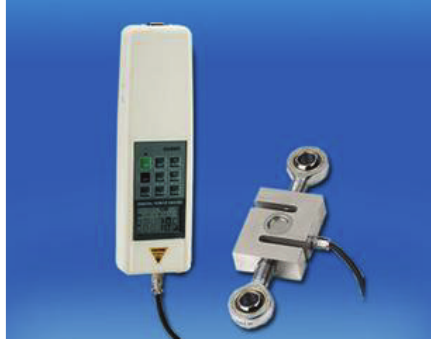
Figure 2: The digital dynamometer.